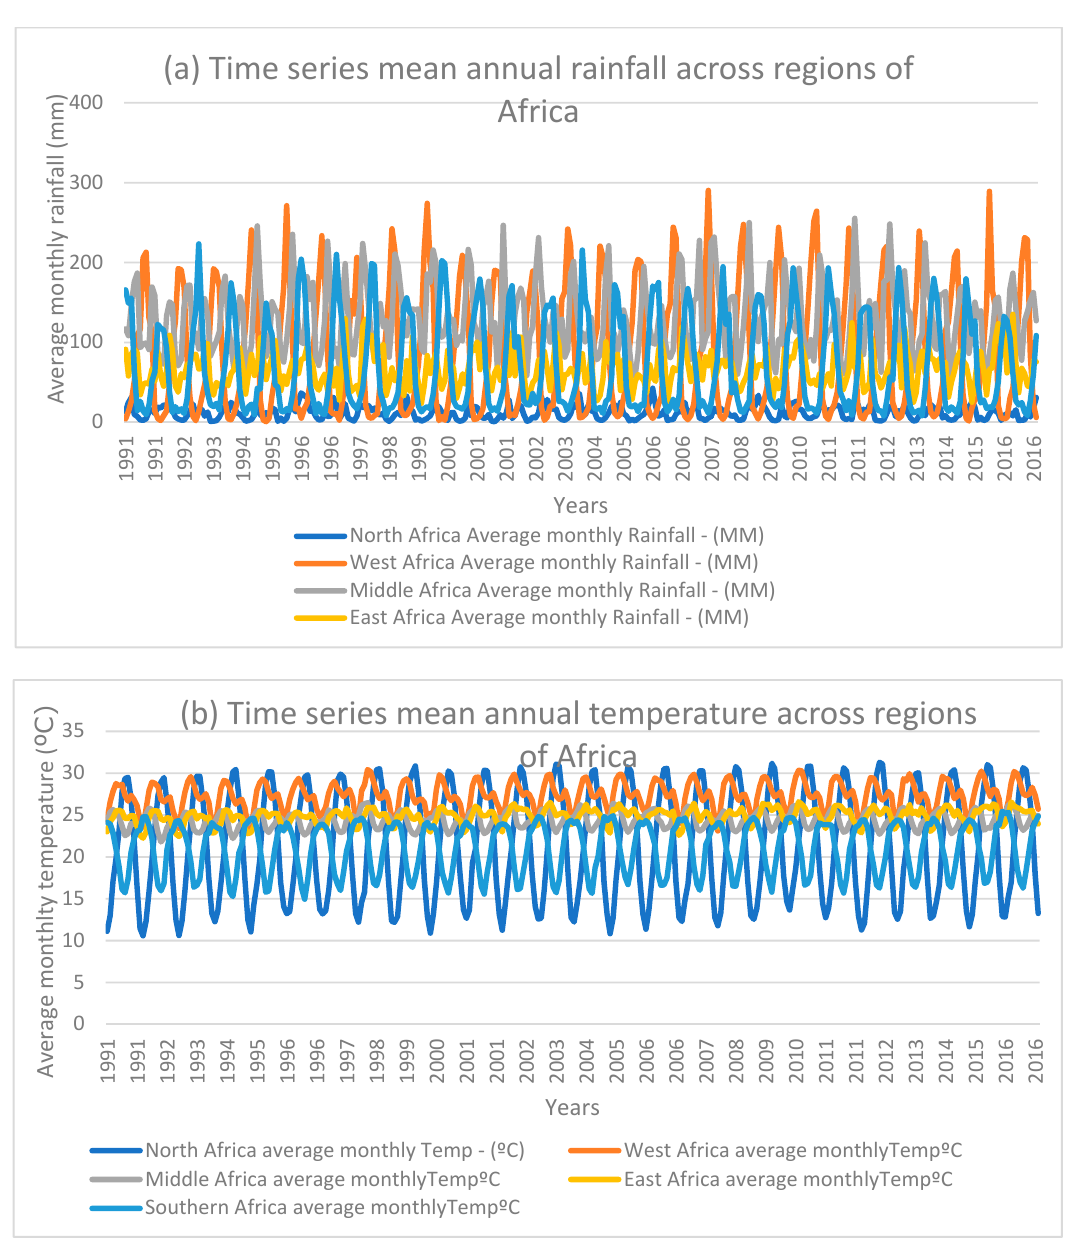
Figure 2. Recent trends in ( a ) mean annual precipitation ( b ) mean annual temperatures across Africa. Source: author’s